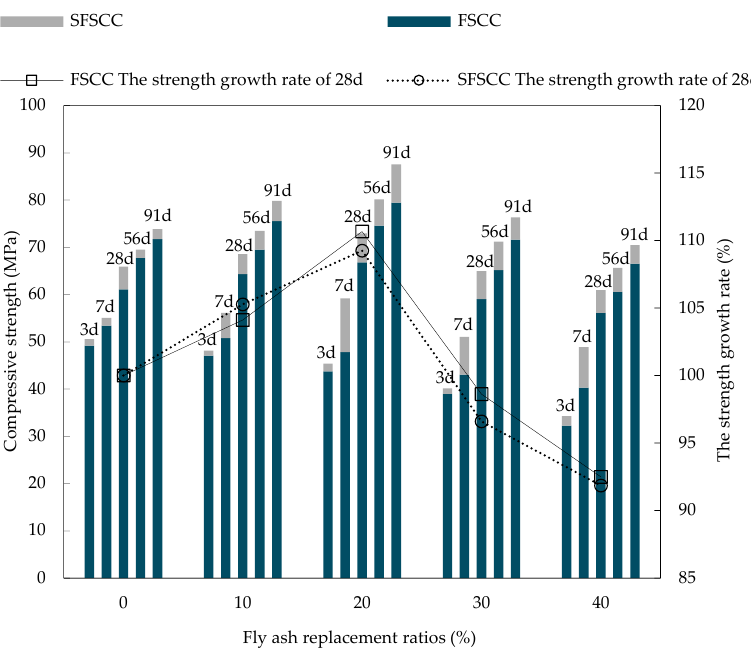
Figure 4. Stress model and loading path of specimen.